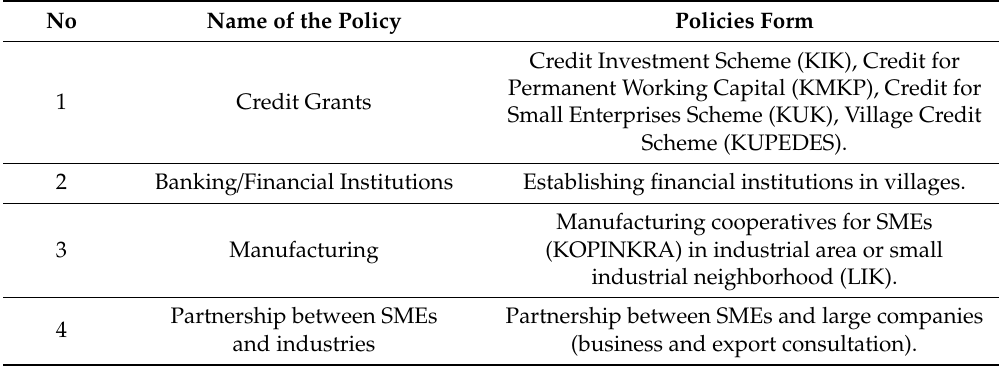
Table 2. Indonesian MSME empowerment